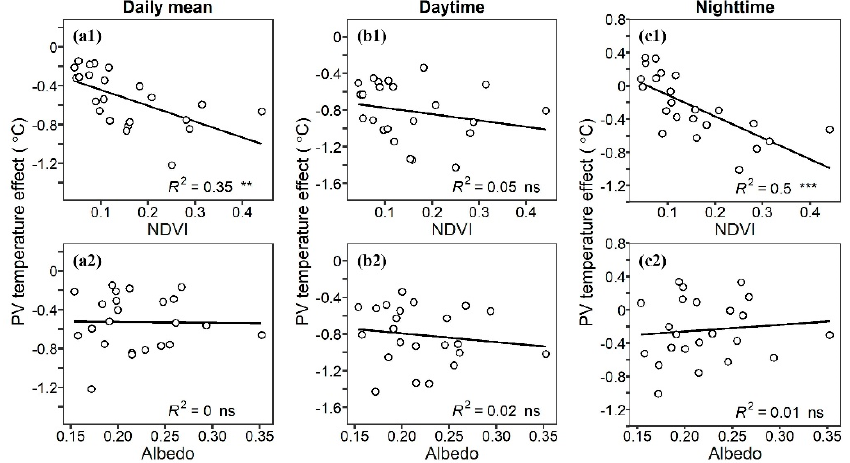
Figure 5. The relationships between annual ( a ) daily mean, ( b ) daytime and ( c ) nighttime PV temperature e ff ect with ( a1 , b1 , c1 ) normalized di ff erence vegetation index (NDVI) and ( a2 , b2 , c2 ) albedo across the 23 PV powerplants. The solid lines are the linear regression lines; ns, *, **, *** and ****: statistically significant at p > 0.05, p < 0.05, p < 0.01, p < 0.001, and p < 0.0001